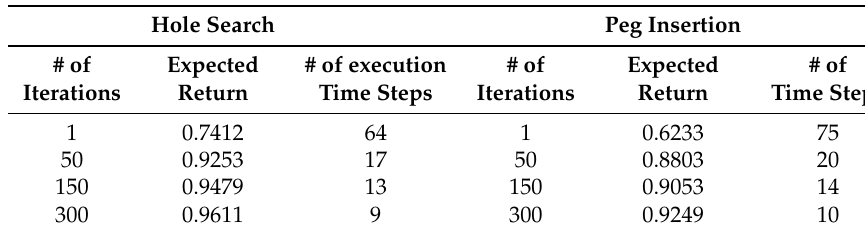
Table 2. Expected returns and the number of execution time steps with respect to the number of iterations for the peg-in-hole task.